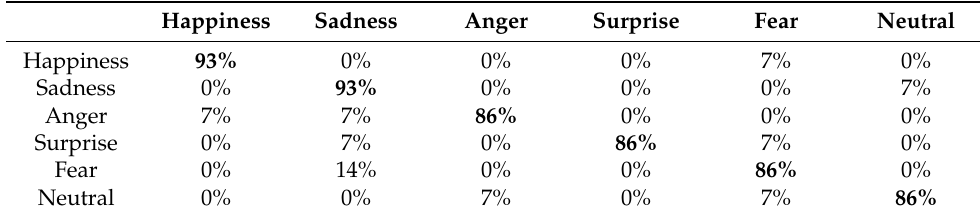
Table 5. Confusion matrix—Real-time system.